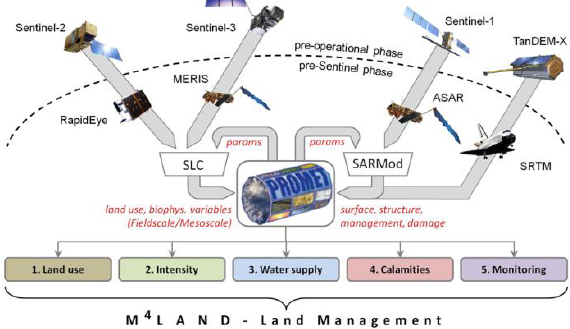
Figure 1. The M 4 Land concept, showing the sensors employed during the development phase as well as in the pre-operational phase after the SENTINEL launch (Klug,